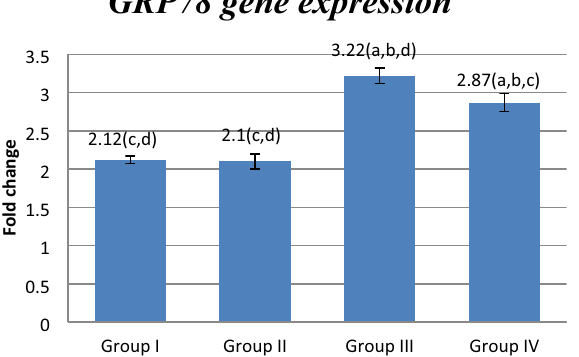
Figure 3. Effect of FUC treatment on GRP78 mRNA gene expression. values are represented as mean ± SD. Data are represented as mean ± SD. Statistical analysis was carried out using one-way ANOVA with Tukey’s post hoc test, SPSS computer program. a–d Significant difference between groups at * p < 0.05. a Significance from group I; b significance from group II; c significance from group III; d significance from group IV. Degree of freedom is (3) between groups and (24) within groups (total = 27).